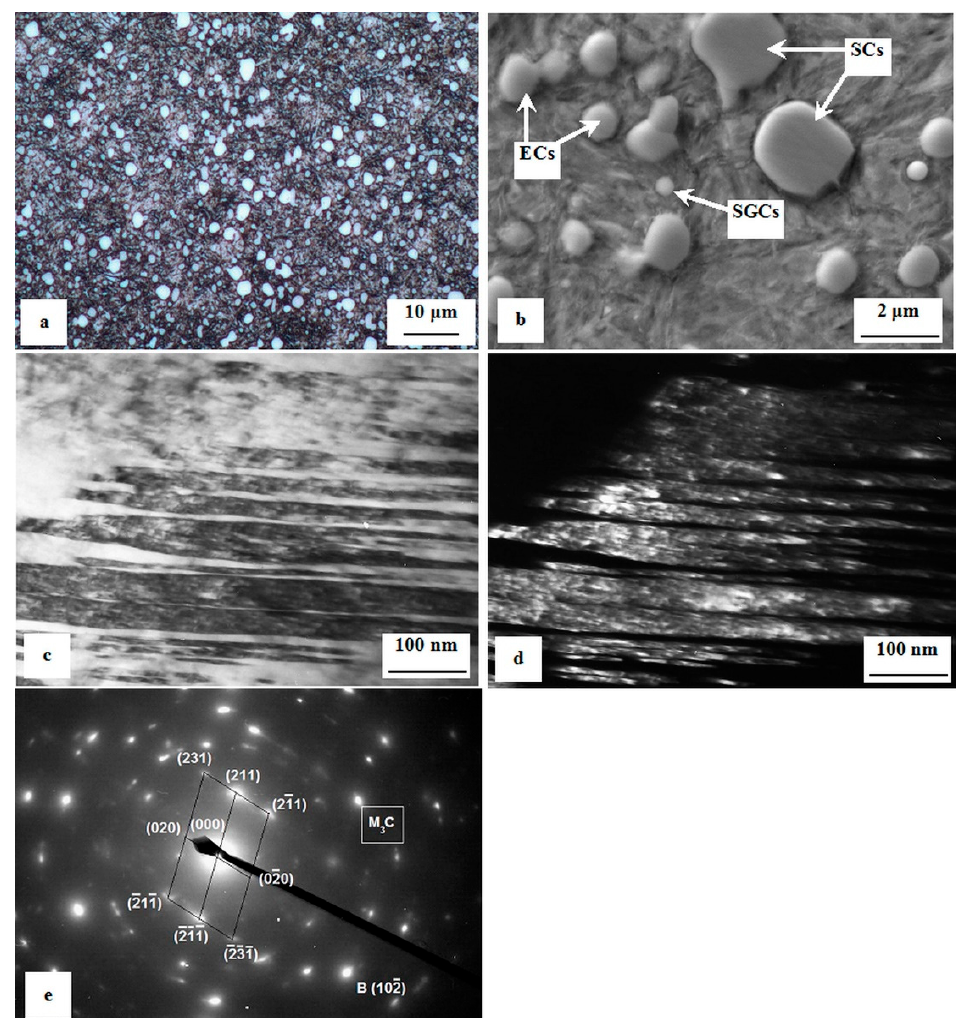
Figure 2. Microstructure of the experimental material after the given heat treatment schedule. ( a ) Optical micrograph, ( b ) SEM micrograph, ( c ) bright-field TEM micrograph showing internally twinned martensitic laths, ( d ) corresponding dark-field micrograph showing precipitates inside the martensitic domain, and ( e ) diffraction patterns of the precipitates.